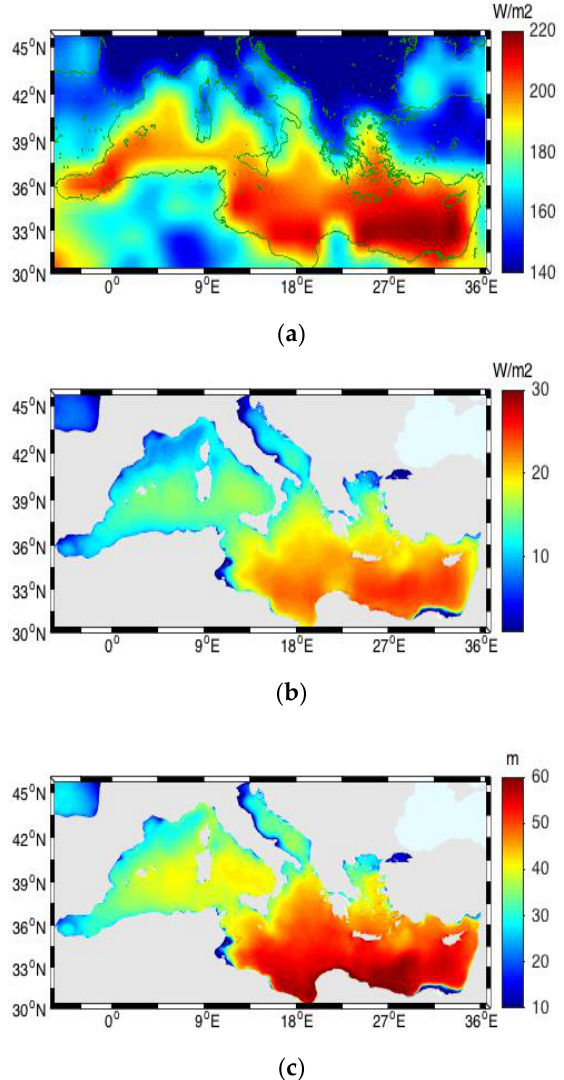
Figure 12. Maps of ( a ) mean climatology of the daily net shortwave radiation flux (NSWRS) based on the ERA Interim data (1982 – 2017); ( b ) mean daily PAR at 15-m depth, estimated from NSWRS (shown in Figure 12a) using Equations (2) and (3); ( c ) depth, where PAR(z) is equal 10% of its surface value.